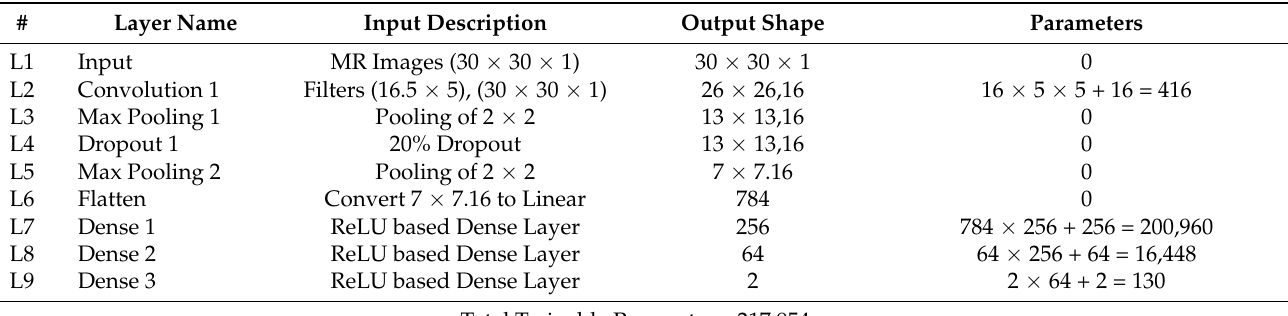
Table 4. Proposed CNN Model 1 for MR Image Classification.